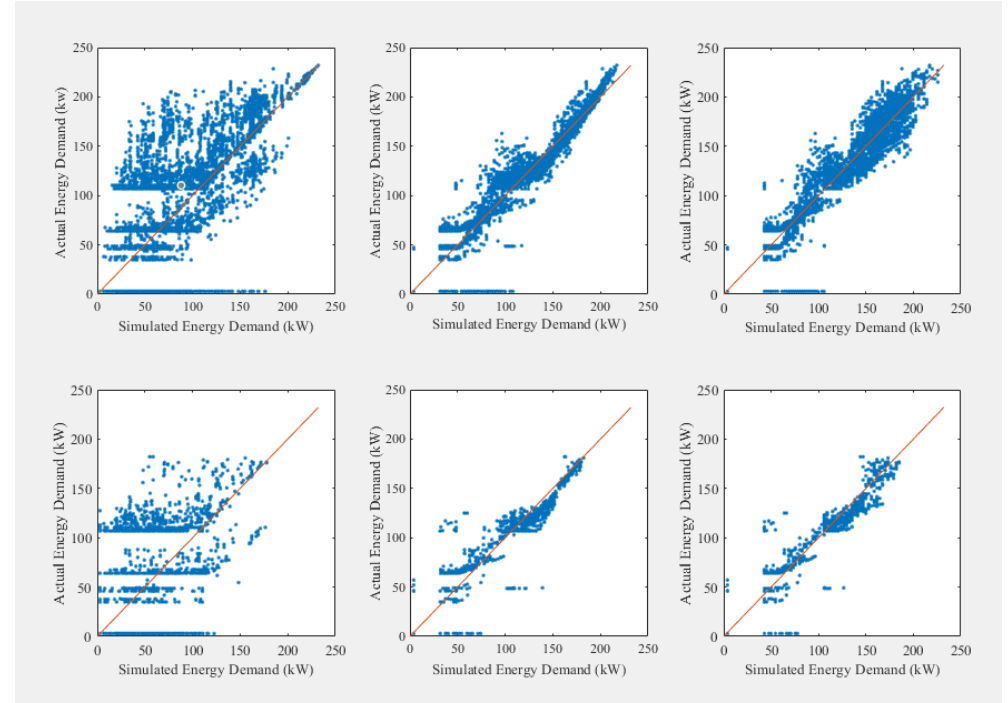
Figure 3. Training ( above ) and testing ( below ) data for the performance of Models 3,4, and 5 for Building 1.